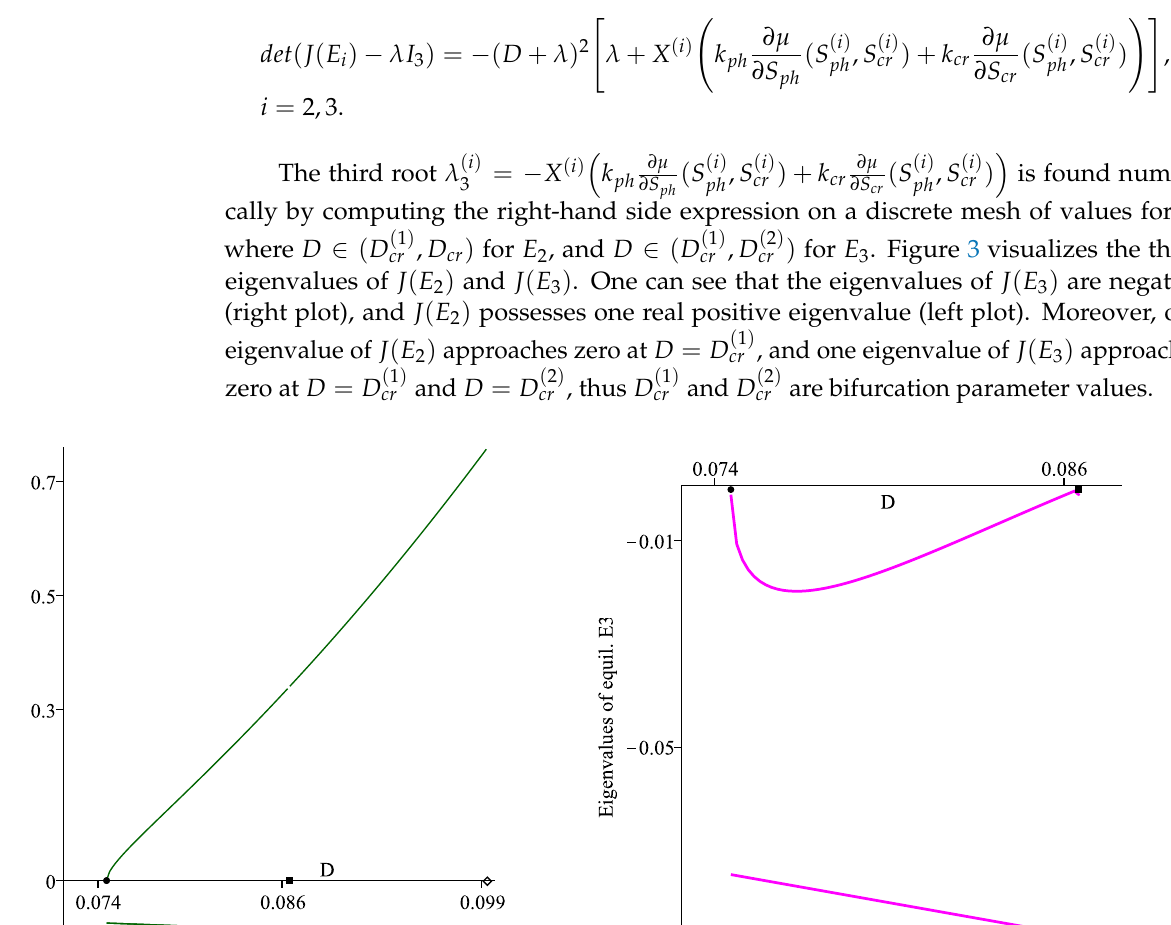
( 1 ) ( 2 ) cr , the solid box denotes D cr , the diamond denotes D cr